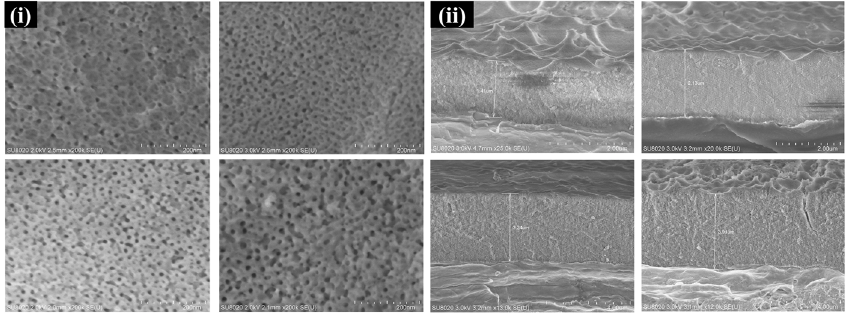
Figure 6. SEM images of anodic aluminum oxides by anodizing AA2524 ( i ) top surface microscopic image and ( ii ) cross ‐ section images at different voltages at (8, 10, 14, and 16 V) [75].